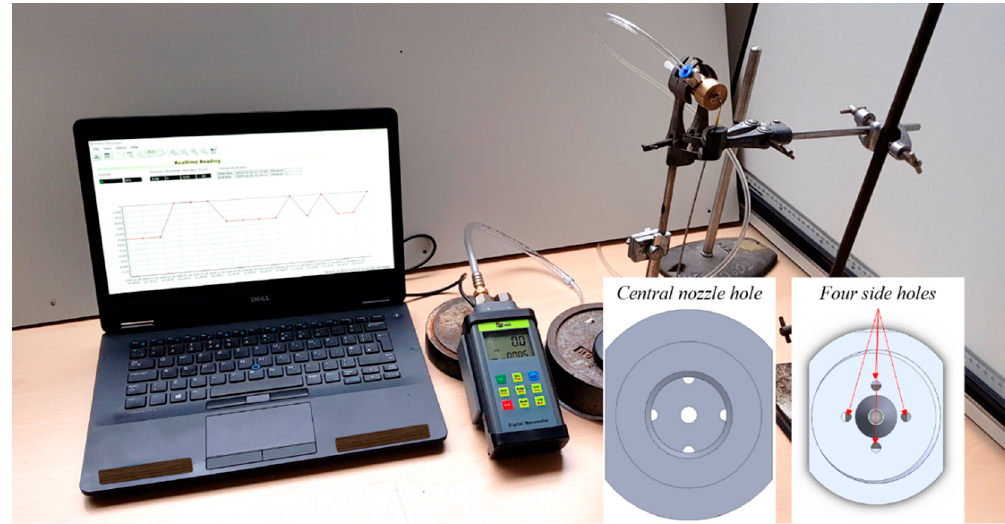
Figure 2. The experimental setup consisting of the pitot tube, SBS nozzle, manometer, and laptop for data logging. Inset shows the central nozzle hole and four side holes for air.